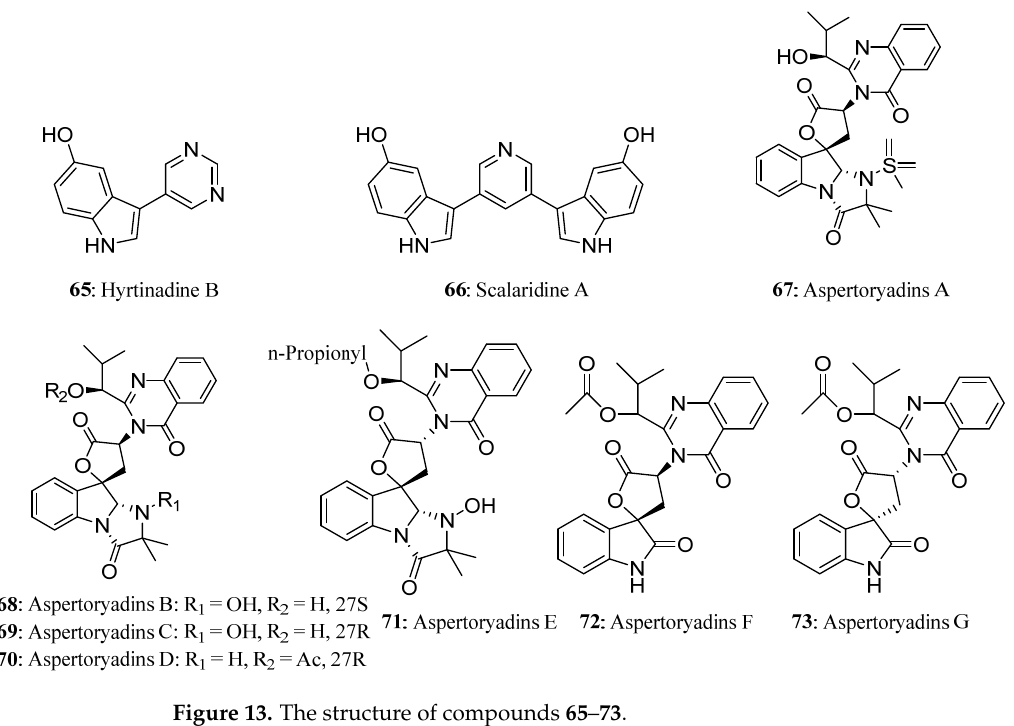
Figure 13. The structure of compounds 65 – 73 .